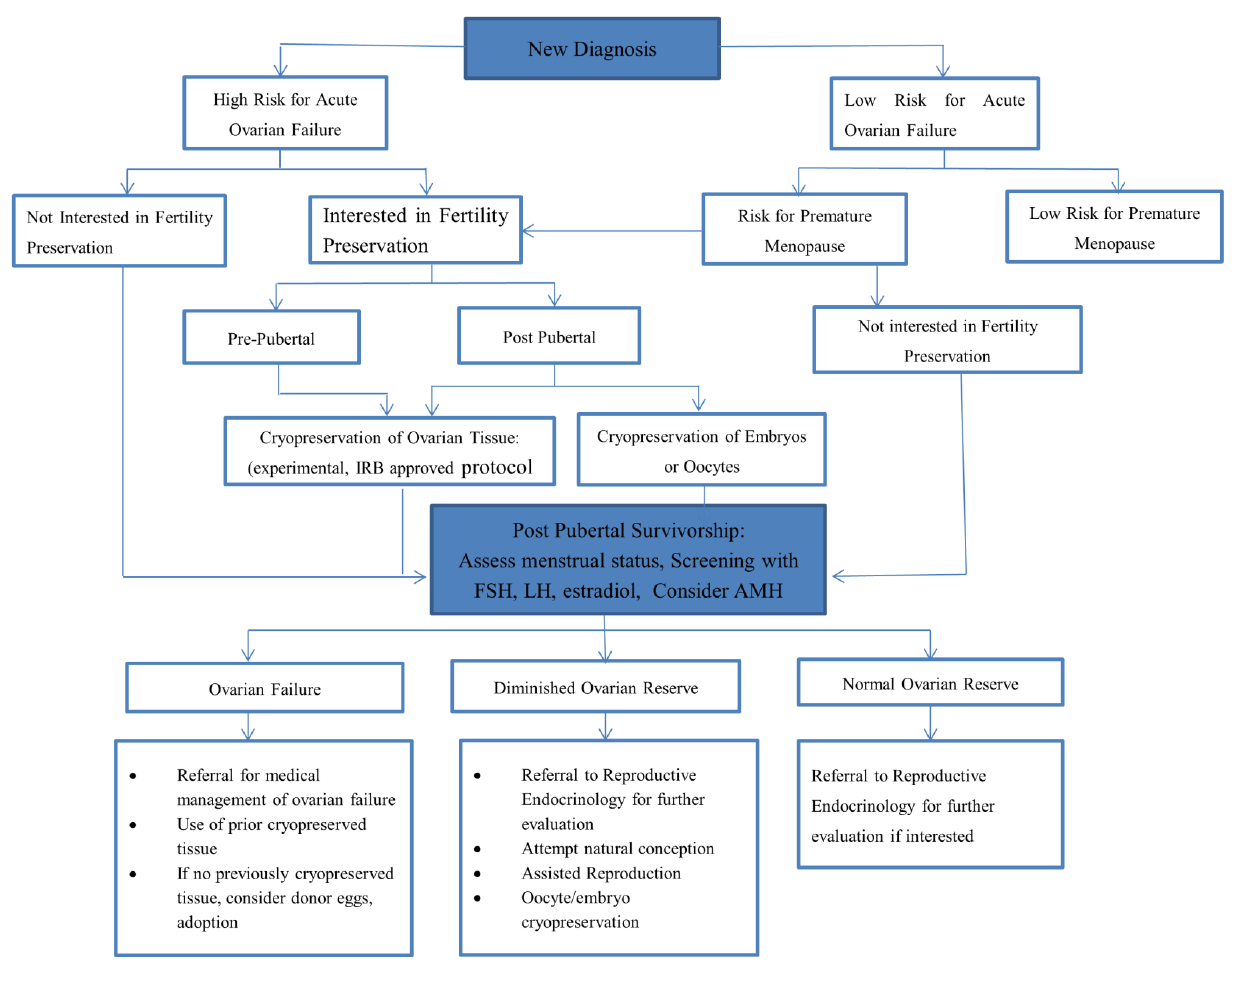
Figure 2. Algorithm for fertility preservation options in